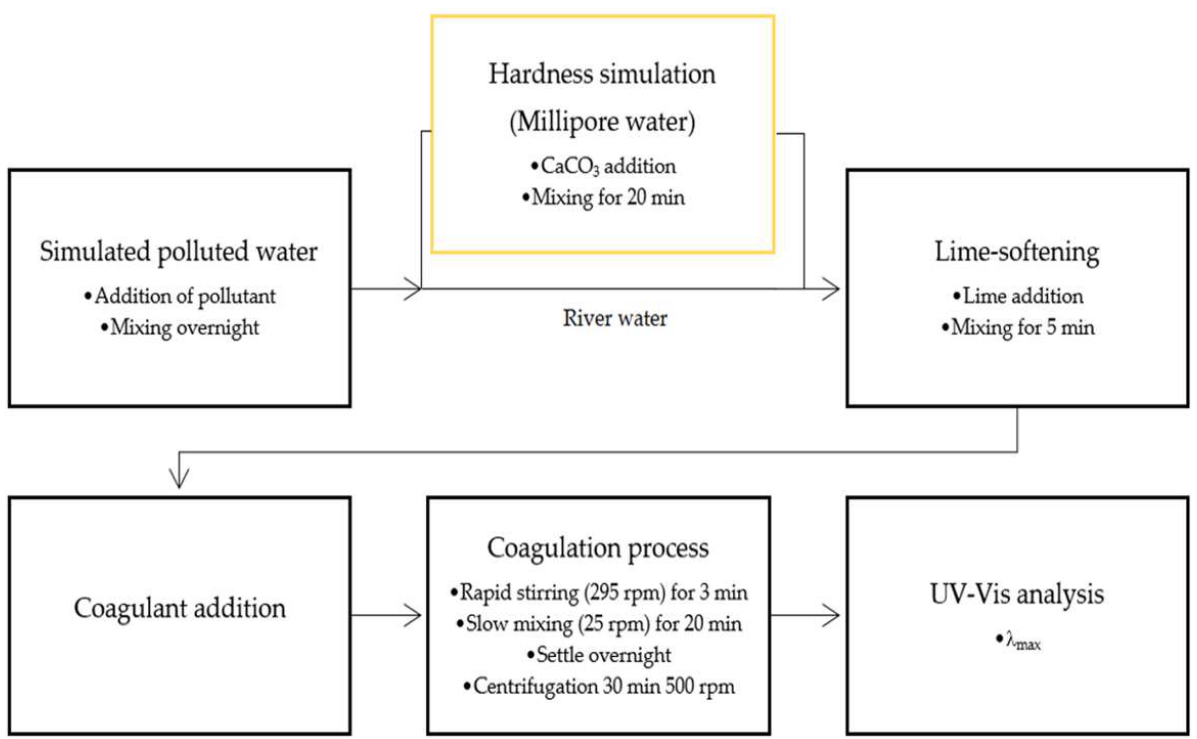
Figure 2. Block diagram for coagulation process for the removal of hydrocarbon oil models from lab (Millipore) versus river water samples.